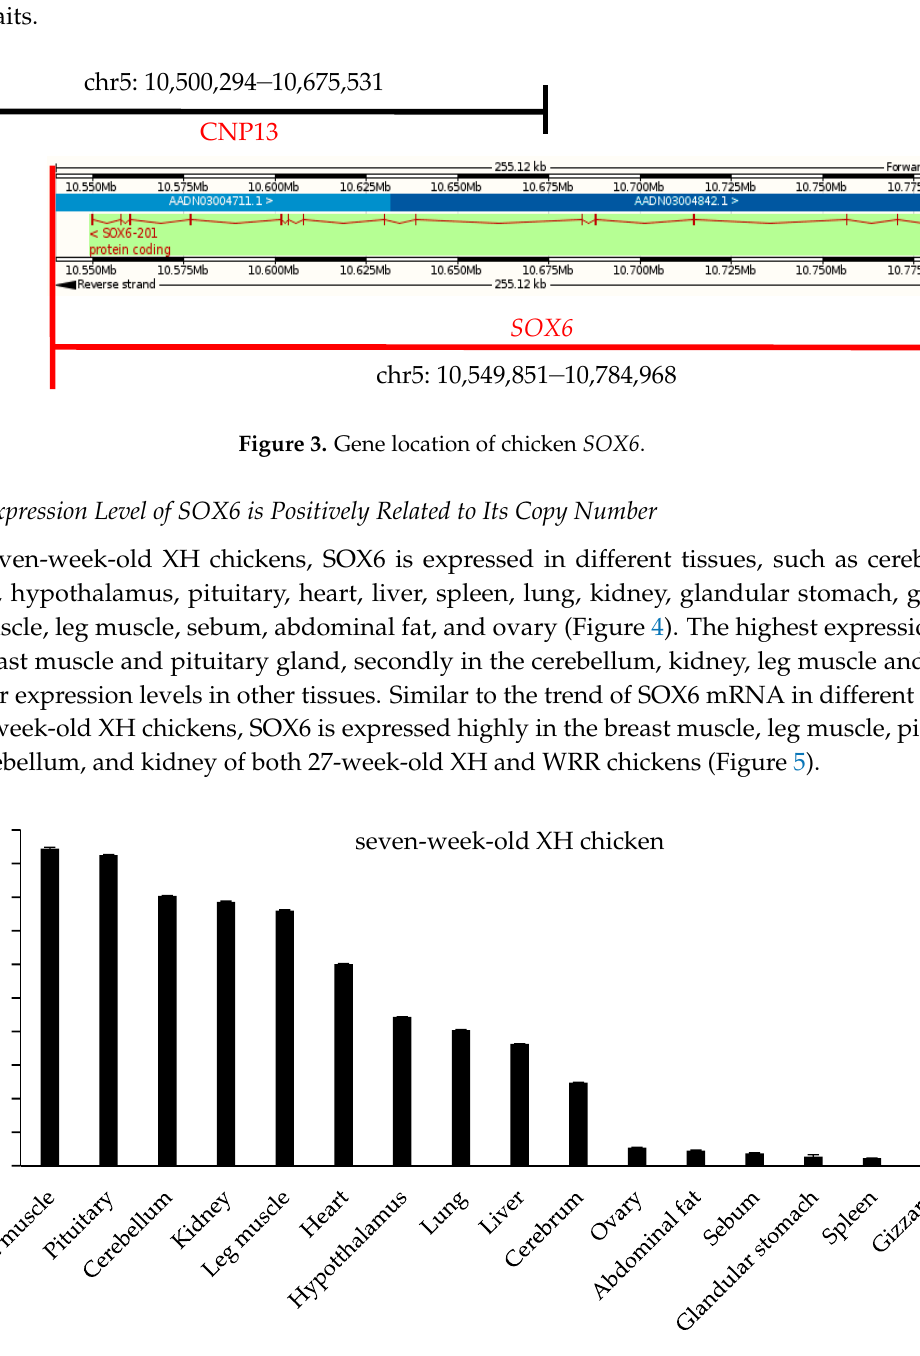
Figure 4. The tissue expression profile of SOX6 in seven-week-old XH chickens.